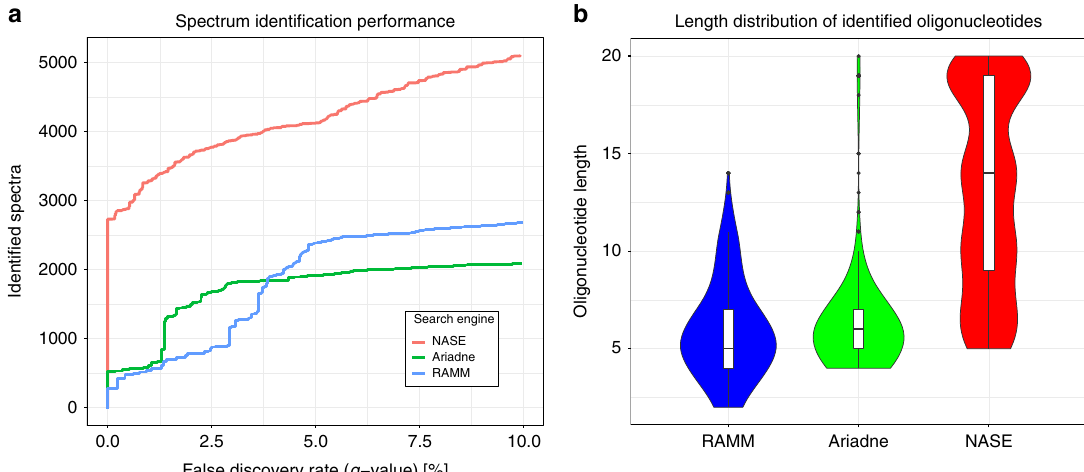
Fig. 2 Performance comparison of RNA identi fi cation engines — Ariadne, RNAModMapper (RAMM) and NucleicAcidSearchEngine (NASE) — based on searches of the NME1 data. a Number of successfully identi fi ed spectra plotted against the q-value, a measure of the false-discovery rate, which was calculated from a target/decoy database search using each of the three tools. b Sequence length distribution of identi fi ed oligonucleotides for each tool at a con fi dence level of 5% FDR, shown using violin and box plots. Box plot center lines indicate data medians, box limits show upper and lower quartiles, whiskers extend to the largest/smallest value no further than 1.5 times the interquartile range from the box, black dots represent